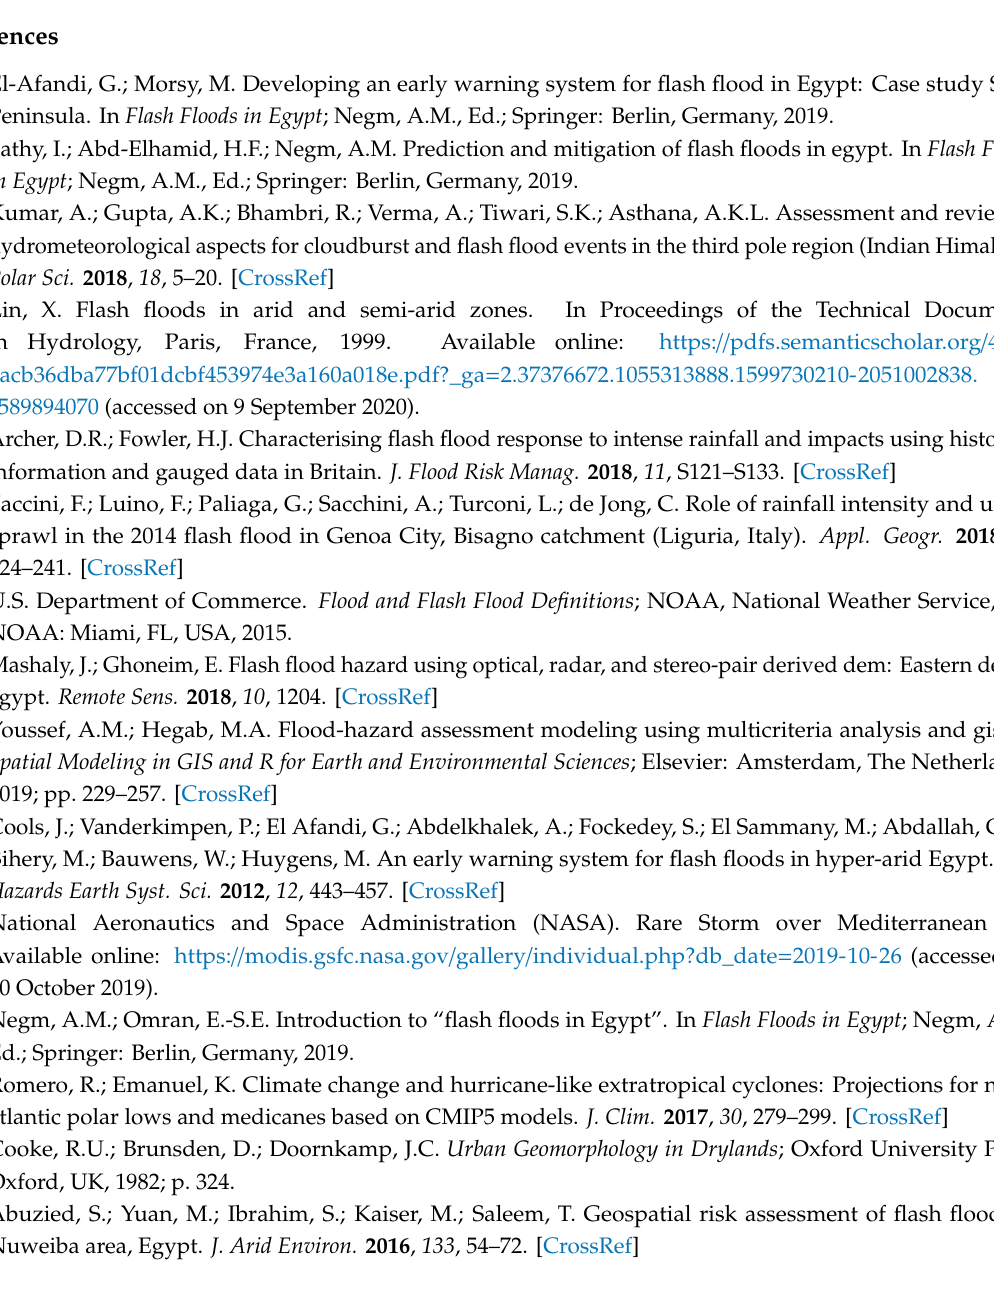
Figure S1: Soil texture in the study region, Table S1. Akaike information criterion for di ff erent fitting